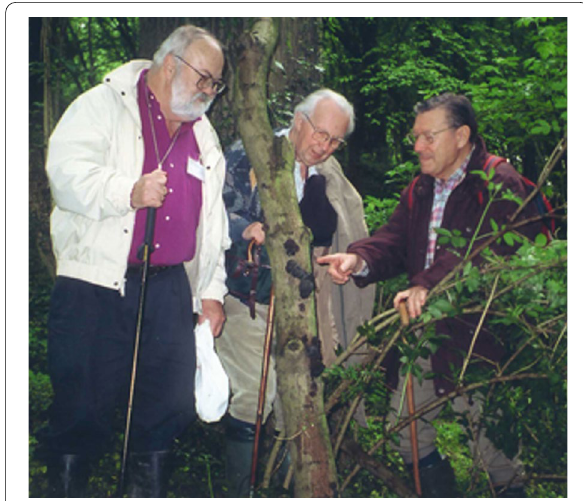
Fig. 26 Jack D. Rogers ( left ) with the German amateur mycologists, Siegfried Woike ( centre ) and Hartmund Wollweber ( right ) in